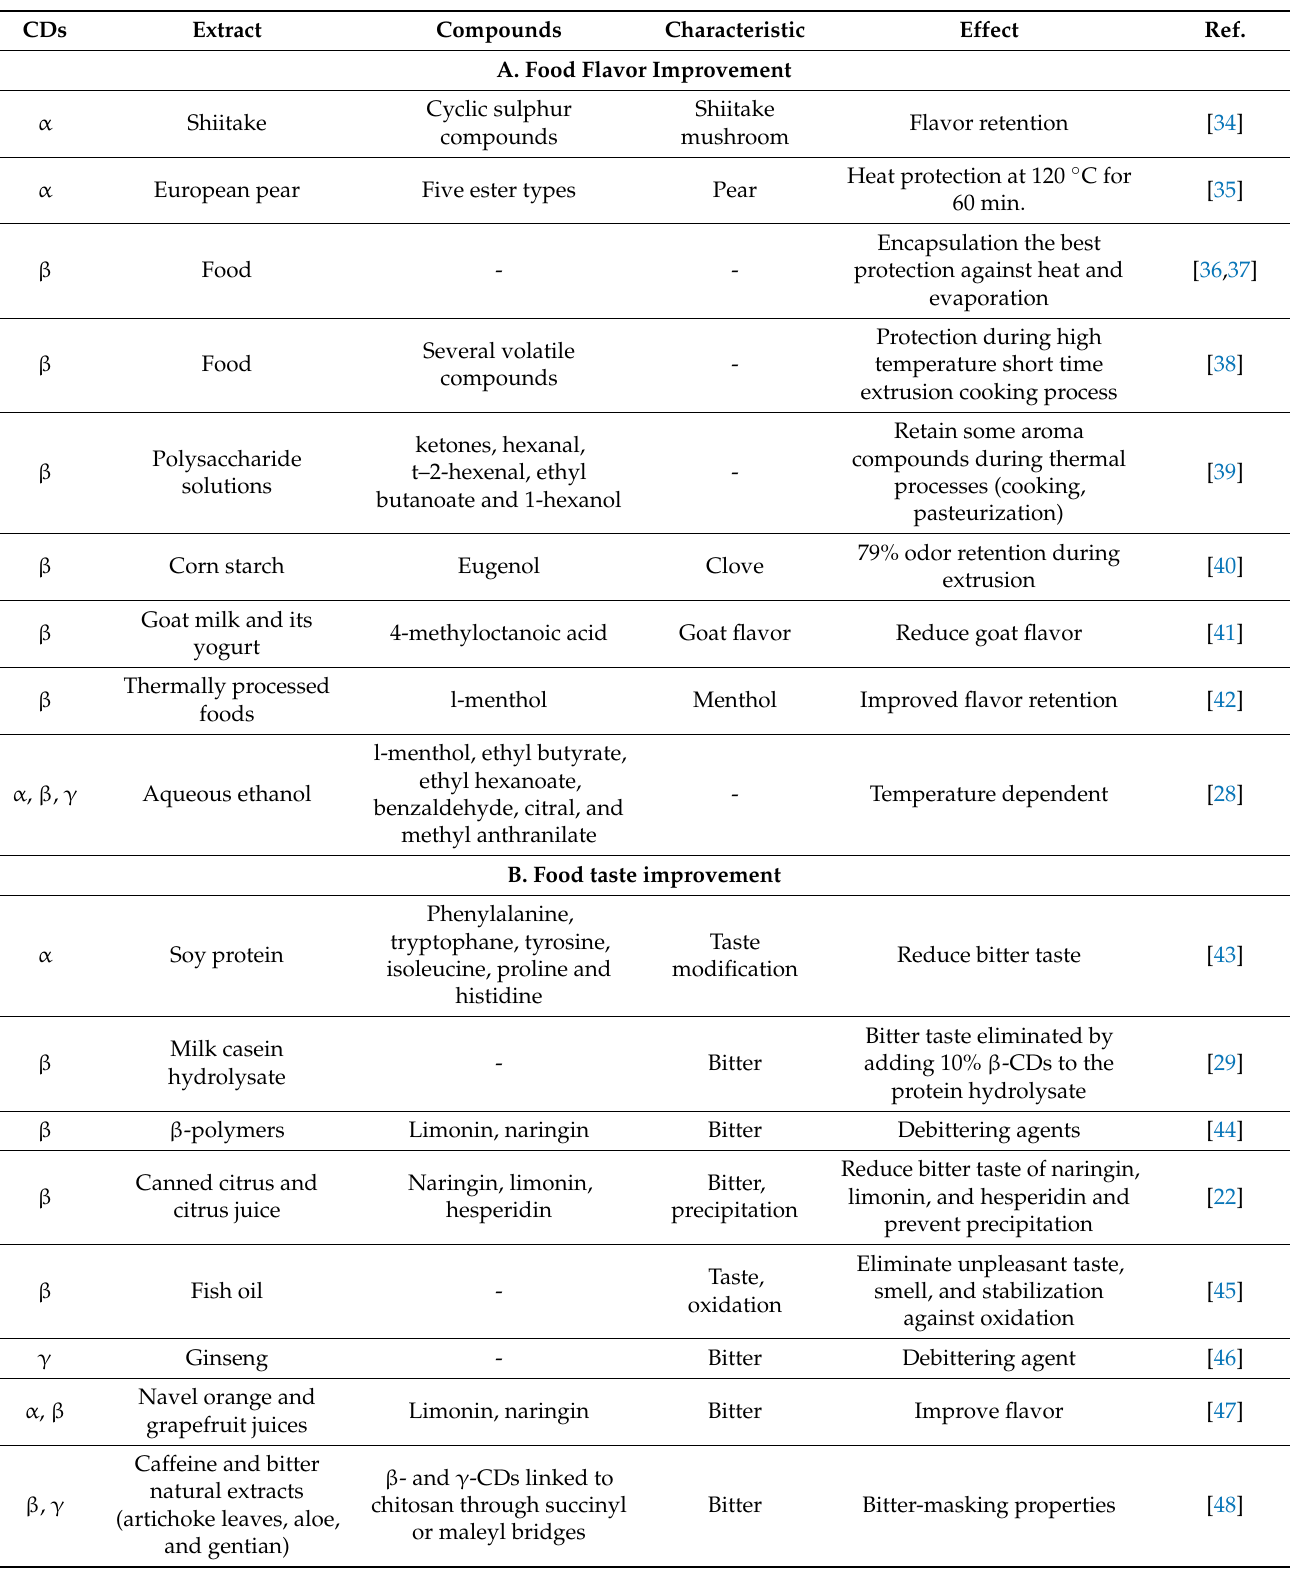
Table 2. Studies of cyclodextrins (CDs) for food flavor and taste